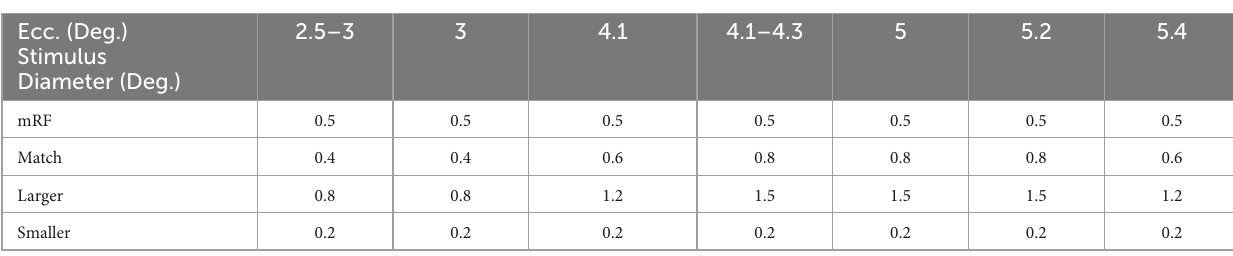
TABLE 1 Size of stimuli in all